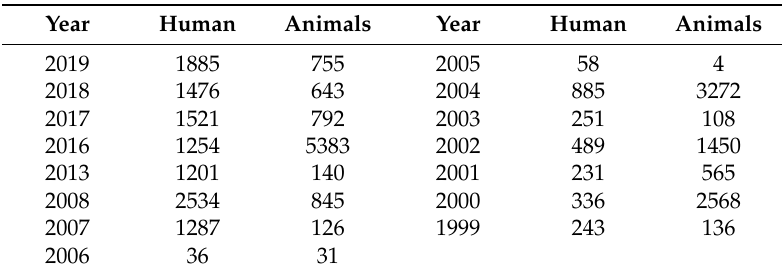
Figure 1. Study area identification, ( a ) location of the study area in Bihar, India, ( b ) flood situation [38]. Table 1. Statistics of loss of lives in floods of Bihar [37].